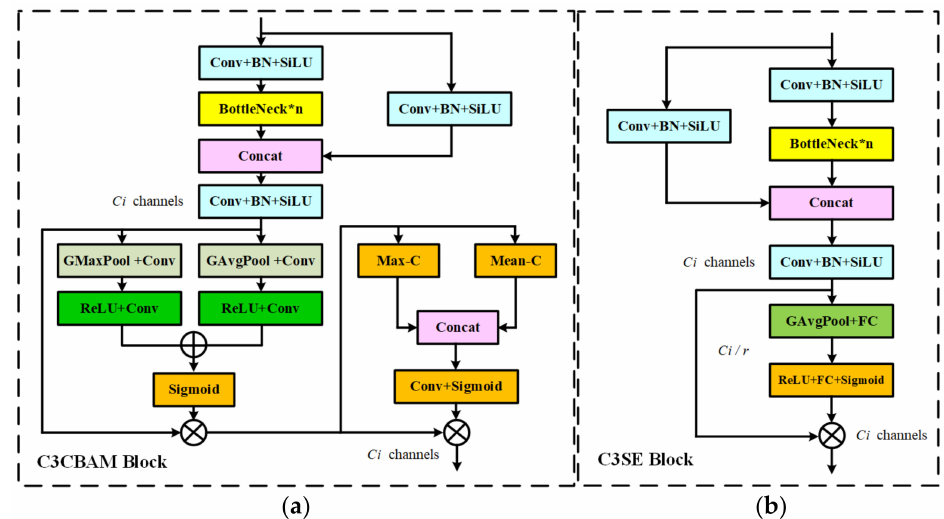
Figure 2. The structures of two proposed different attention blocks. ( a ) The C3SE block; ( b ) The C3CBAM block. “ Ci ” represents the number of feature channels, “Conv” means the ordinary convolution-2D layer, “BN” means the batch normalization layer, “SiLU” means swish function, “BottleNeck” is formed by stacking multiple convolution layers, “GAvgPool” means the global aver- age pooling-2D layer; “GMaxPool” means the global max pooling-2D layer; “FC” means the fully connection layer, and the “r” is a reduction factor, “Max-C“ represents the maximum-channel-pixel, “Mean-C” means the